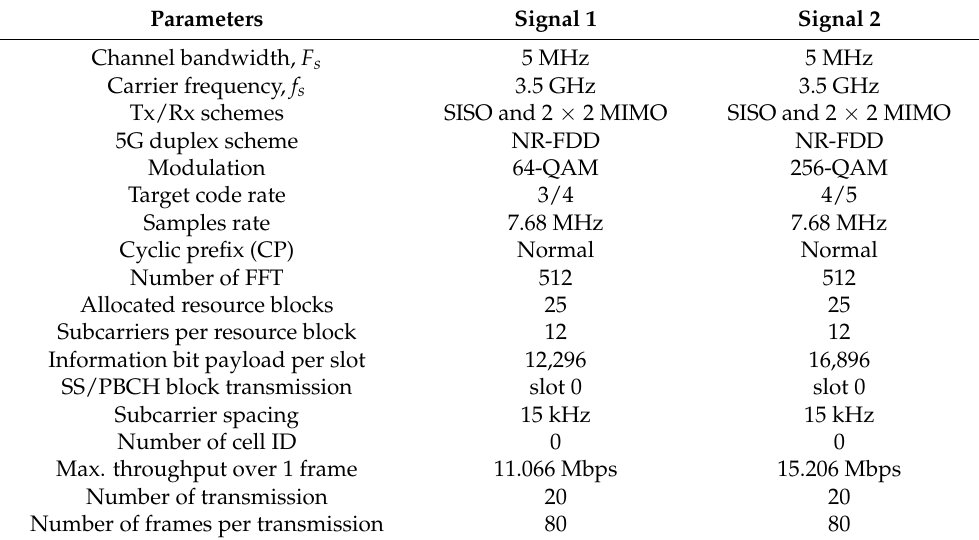
Table 1. Main parameters to emulate the gnodeB. Parameters Signal 1 Signal